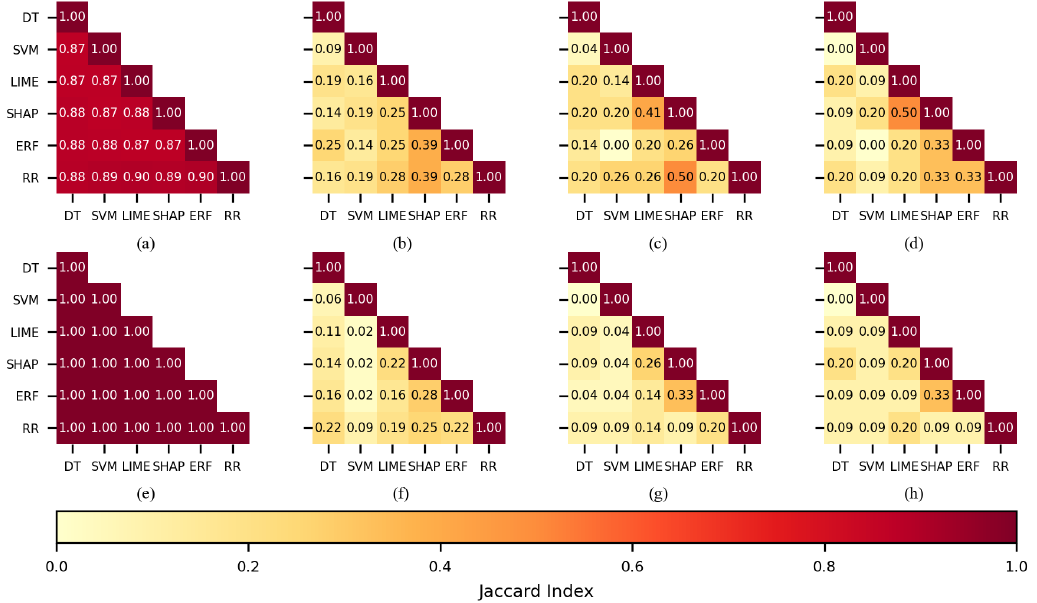
Figure 10. The similarity of the sets of features selected per each feature selection method when RF was used as a classifier. CHB-MIT dataset: ( a ) best 450 features, ( b ) best 150, ( c ) best 100, and ( d ) best 50. Siena dataset: ( e ) best 450 features, ( f ) best 150, ( g ) best 100, and ( h ) best